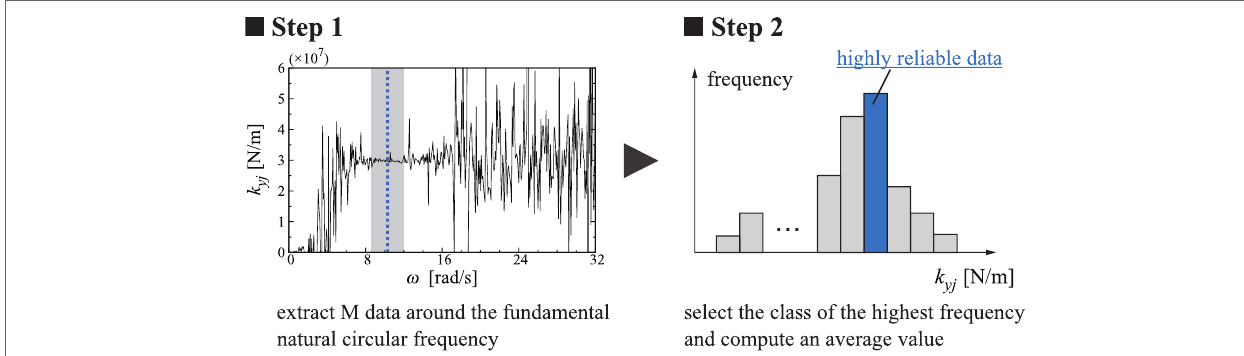
FIGURE 2 | Identification procedure in frequency domain (Steps 1–2).